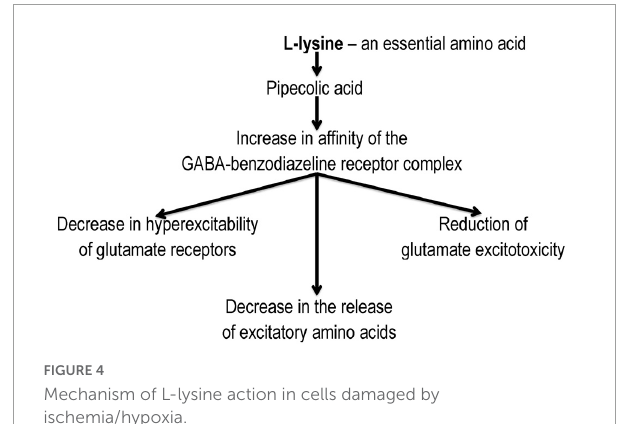
FIGURE4 Mechanism of L-lysine action in cells damaged by